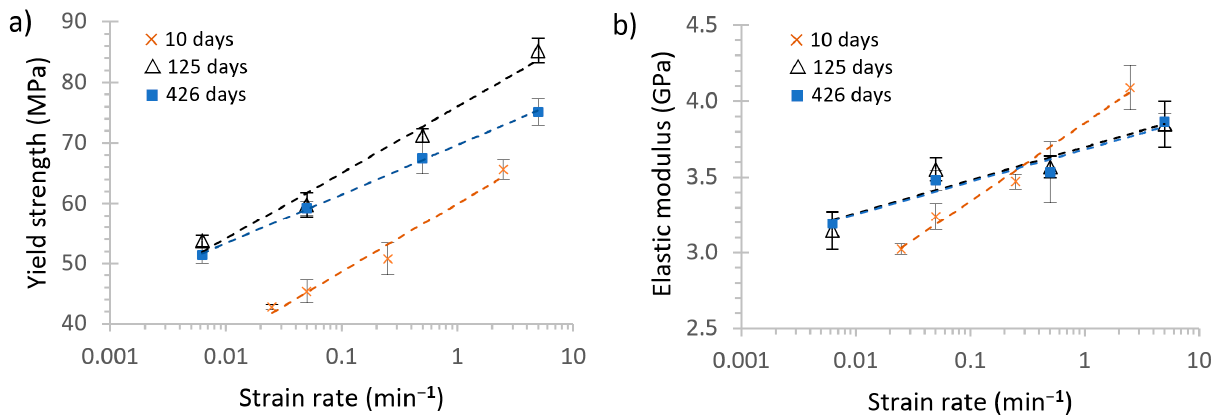
Figure 9. Strain rate in semi-logarithmic scale for PLA naturally aged for 10, 125, and 426 days vs. ( a ) yield strength and ( b ) elastic modulus. Logarithmic fittings are shown with dashed lines.